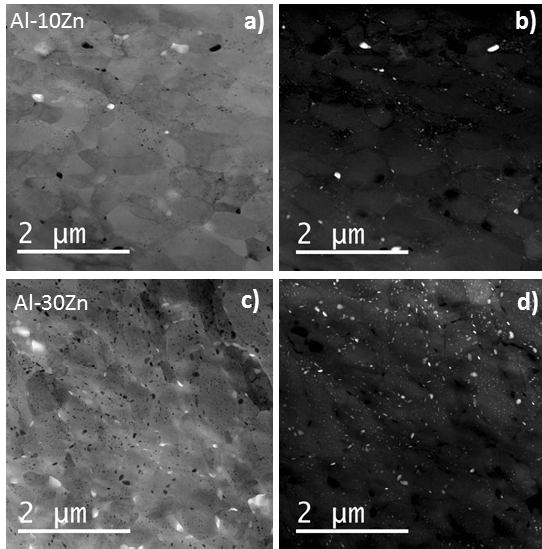
Fig. 1. (a, c) - STEM-BF and (b, d) - STEM-HAADF images showing the microstructure of the (a, b) - Al-10Zn and (c, d) - Al-30Zn alloys after SPD.